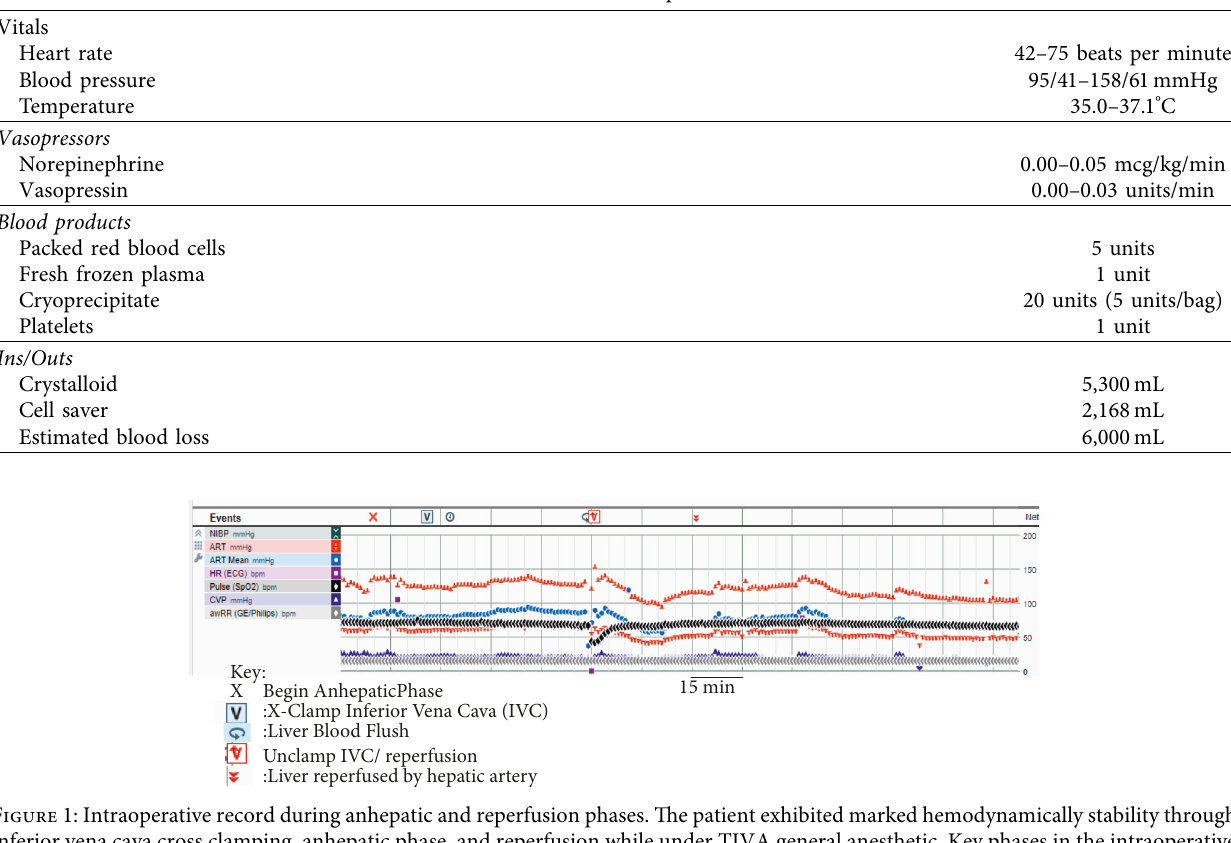
Table 1: Relevant intraoperative